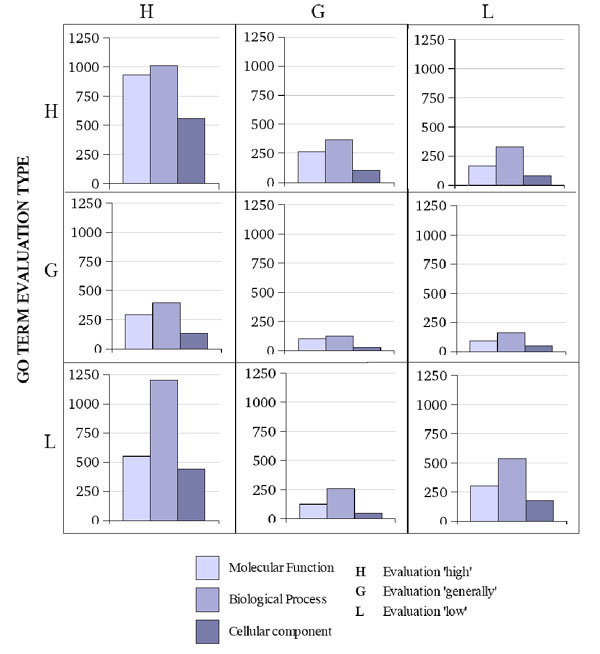
Task 2.1 Evaluation of the annotation predictions depending on the GO categories. Evaluation of task 2.1 prediction depending on the evaluation type and the GO categories. H: high (correct prediction), G: generally (overall correct but too general to be of practical use) and L: low (basically wrong predictions). The GO categories are CC: Cellular Component, MF: Molecular Function and BP: Biological Process. Notice that only the entirely evaluated predictions are displayed.